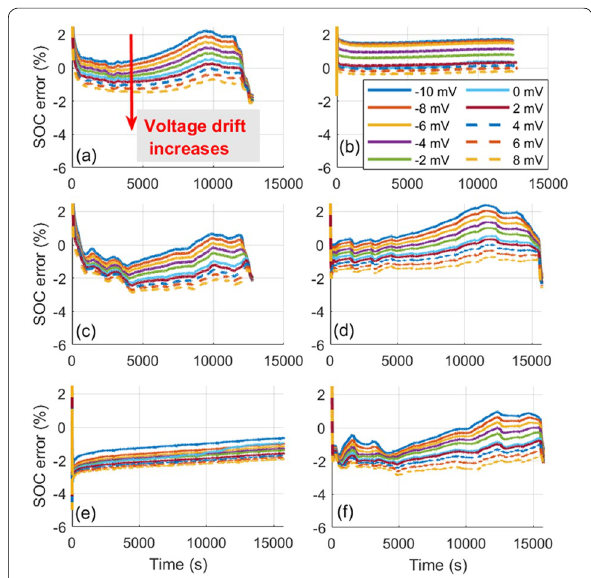
Figure 14 SOC estimation errors under different voltage drift: a R(RQ) for DST profile, b R(RWQ) for DST profile, c R(RQ)(RQ)W for DST profile, d R(RQ) for UDDS profile, e R(RWQ) for UDDS profile, f R(RQ) (RQ)W for UDDS profile